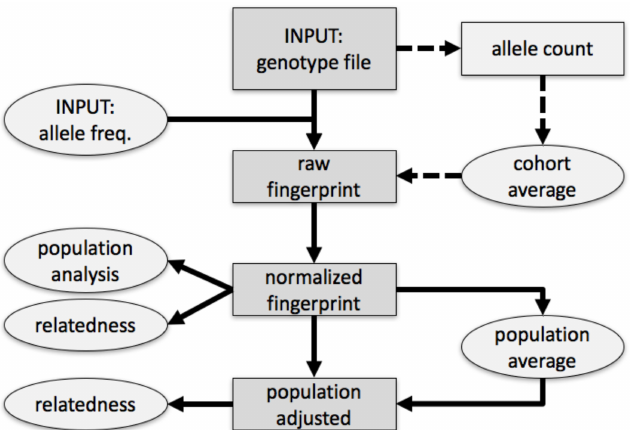
Figure 1. Overview of method. Single nucleotide polymorphisms (SNPs) in the input genotype file were encoded into a table (raw) by observed alleles and rsid numerical value, considering allele frequencies. This could optionally be approximated by subtracting allele counts estimated from a simple model of an observed cohort (dashed arrows). The raw fingerprint was then normalized and could be adjusted to represent deviation from the center of the closest population. Rectangles and ellipses pertain to individual genotypes or to multiple genotypes, respectively; darker gray denotes the flow of information for one genotype from the input file to the normalized and adjusted